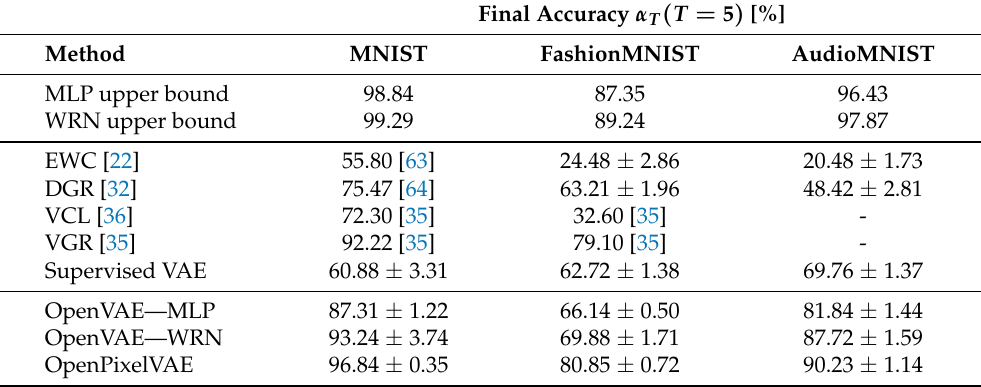
Table 3. The accuracy α T at the end of the last increment T = 5 for class incremental learning approaches averaged over five runs. For a fair comparison, if our re-implementation of related works achieved a better than original value, we report our number, otherwise the work that reported the specific best value is cited right next to the result. Intermediate results can be found in Appendix